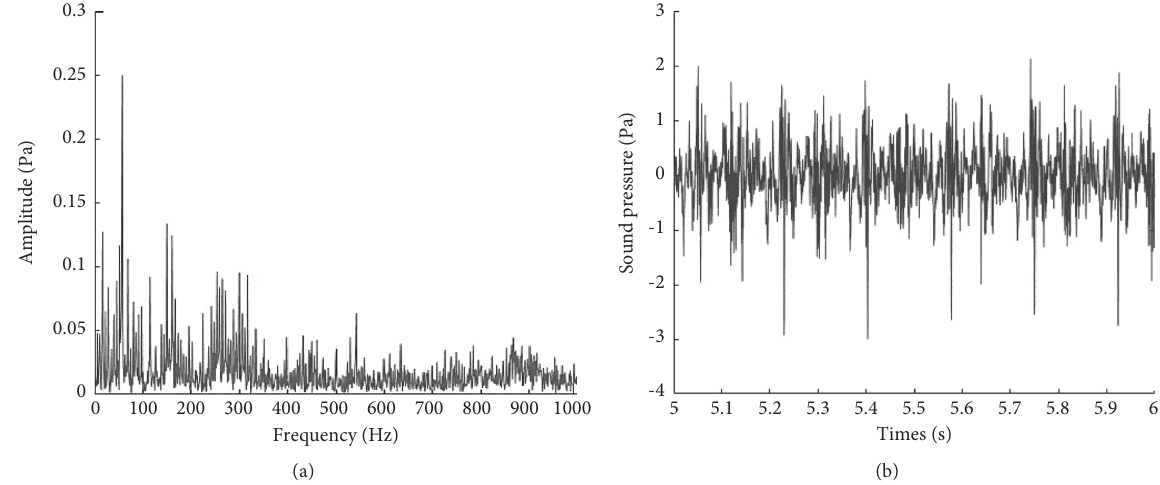
Figure 3: The pretreatment of the noise signal. (a) Amplitude-frequency of the noise signal. (b) Amplitude-time of the noise signal.